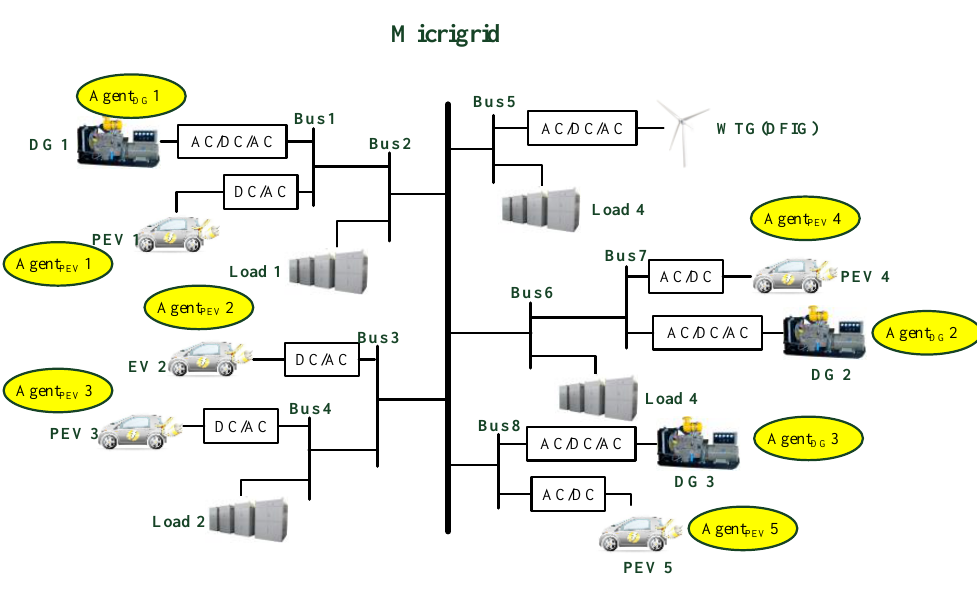
Figure 1. Microgrid architecture.